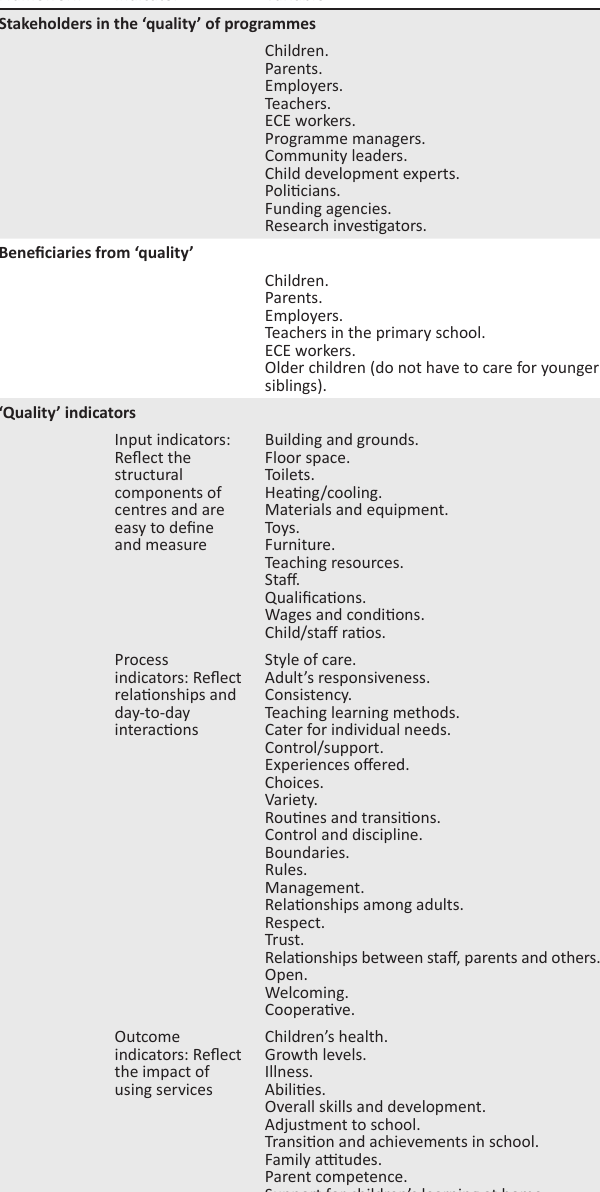
TABLE 1: The theoretical framework for indicating quality in early learning centres.